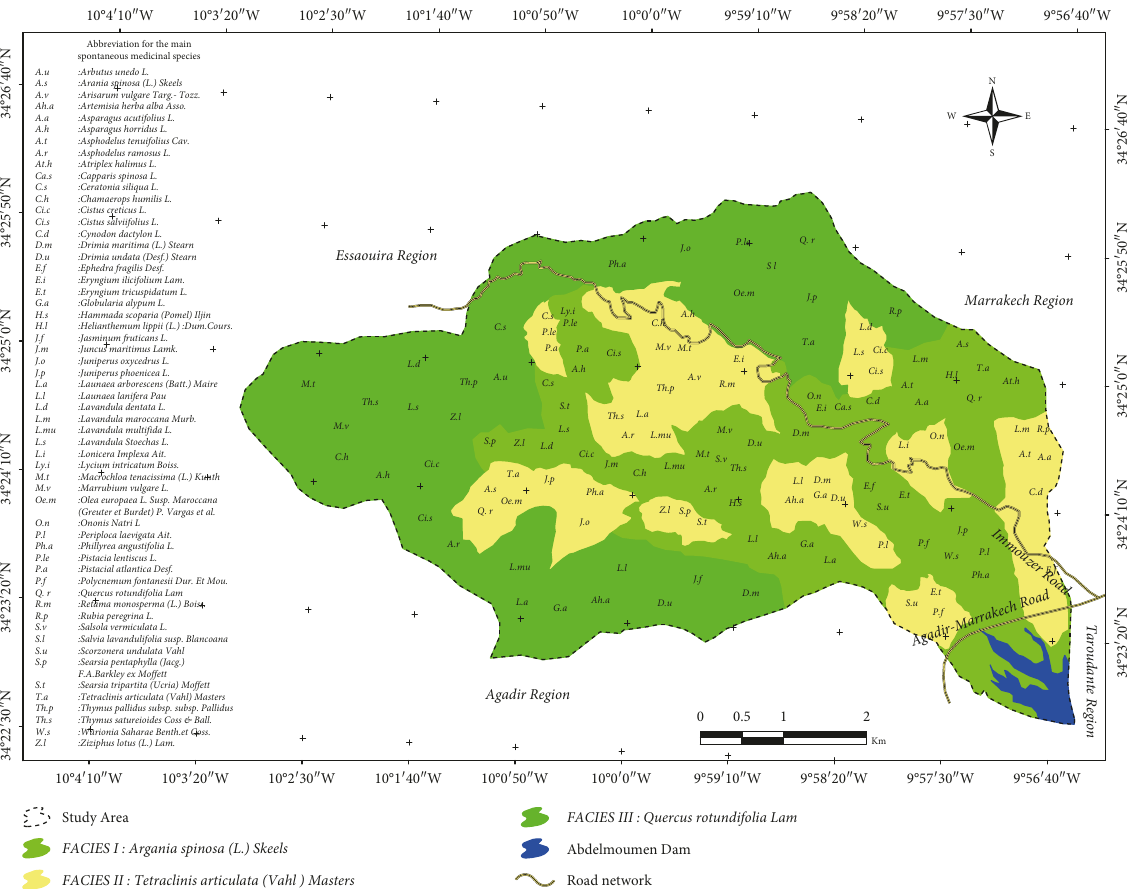
FACIES III : Quercus rotundifolia Lam Abdelmoumen Dam Road network